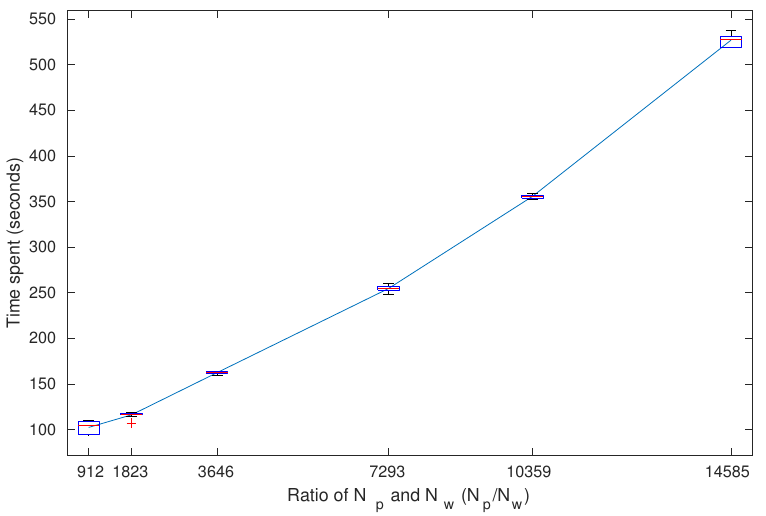
Figure 10. Time spent by data